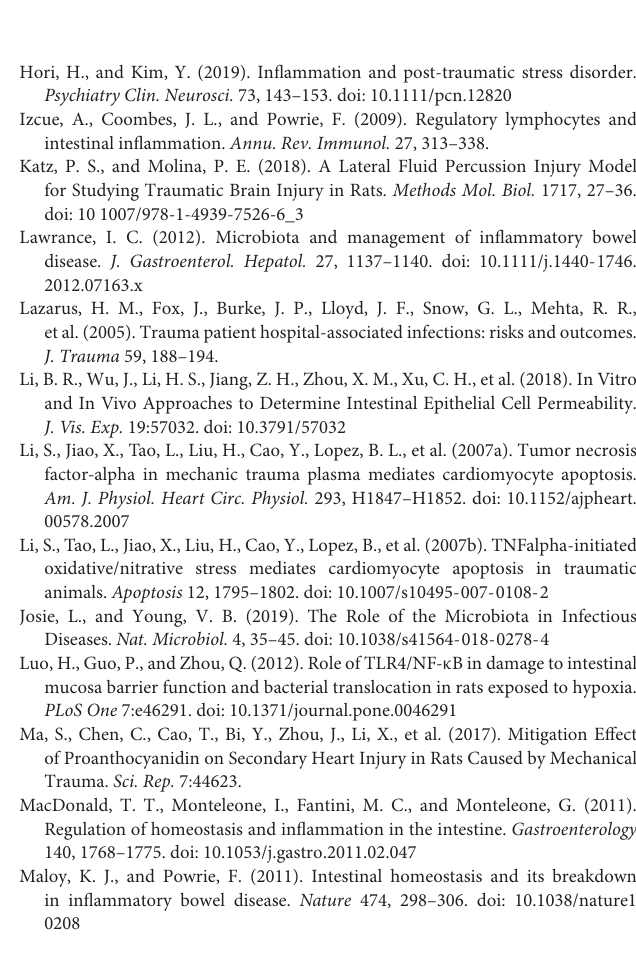
Supplementary Figure 1 | Instrument used to perform the mechanical trauma. Supplementary Figure 2 | The control group. Supplementary Figure 3 | The MT group. Supplementary Video 1 | The control group. Supplementary Video 2 | The MT